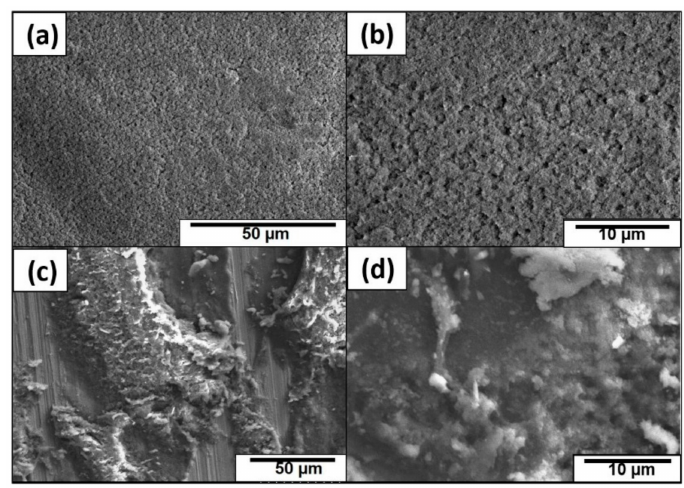
Figure 13. SEM images of the superhydrophobic aluminum surfaces with the Coating B: ( a , b ) surface layer before Taber abrasion test at different magnifications; ( c , d ) surface layer after 30 cycles of Taber abrasion test at different